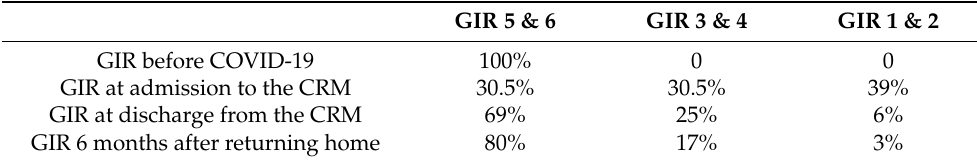
Table 2. Evolution of the patients’ autonomy from before COVID-19 infection to 6 months following their return